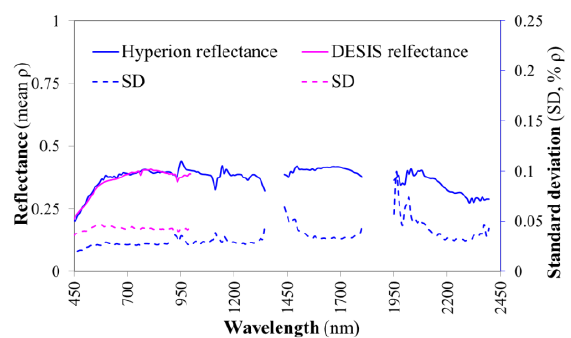
Figure 1 . Mean reflectance magnitude (solid lines) and variation (SD, dashed lines) at Railroad Valley Playa (RRVP) as measured by Hyperion (n=15, 10 nm, blue) and DESIS (n=11, 2.5 nm, pink).